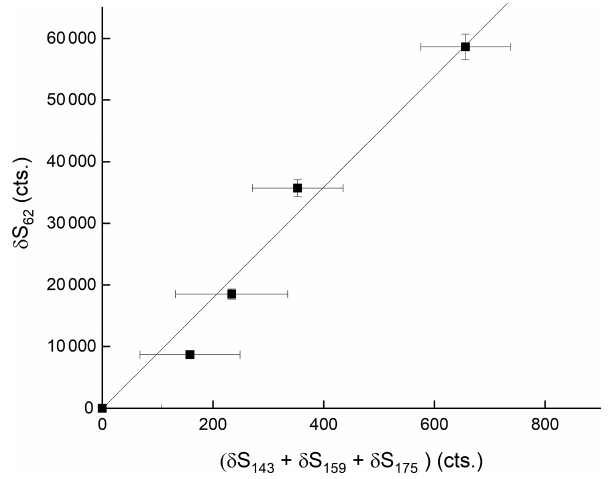
Figure 6. Relative changes in the sum of signals at m/z 143 (IO − ), m/z 159 (IO 2 − ) and m/z 175 (IO 3 − ) when adding up to 80ppbv of HNO 3 . δ refers to the change in signal upon adding HNO 3 and thus takes background signals at each mass-to-charge ratio into account.